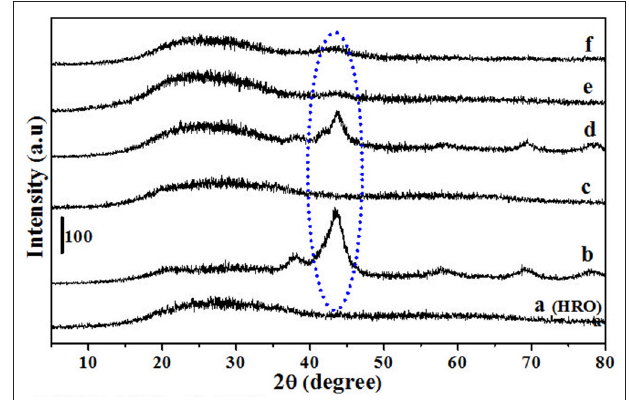
FIGURE 11 | PXRD of (a) HRO Ru-HRO-1. The denotation of (b–f) mentioned in Table 3 .